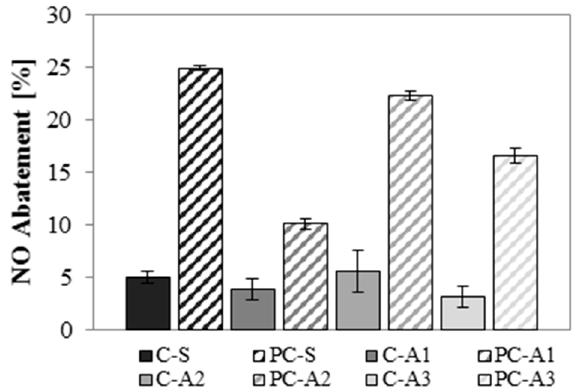
Figure 11. Photocatalytic efficiency under UVA radiation of mortars.